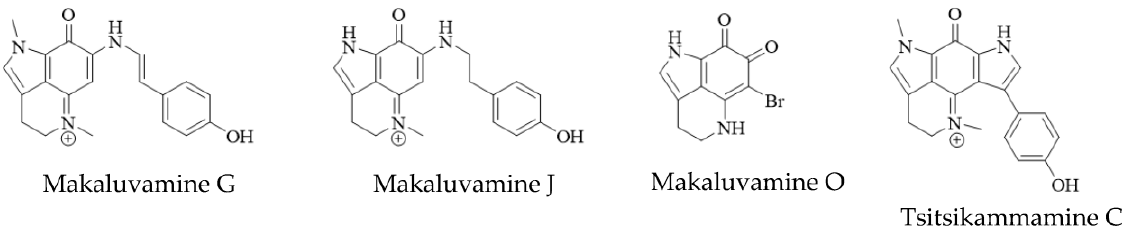
Figure 9. Selected pyrroloiminoquinones and related compounds with antiplasmodial potential.